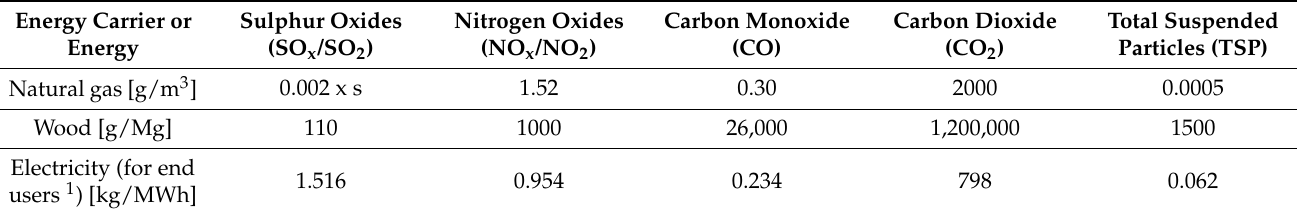
Table 2. Indicators of pollutant emission from fuel combustion (boilers below 0.5 MW) and for electricity. s—sulphur content in milligrams per m 3 [Mg/m 3 ]. Source: own study based on [20–22]. Energy Carrier